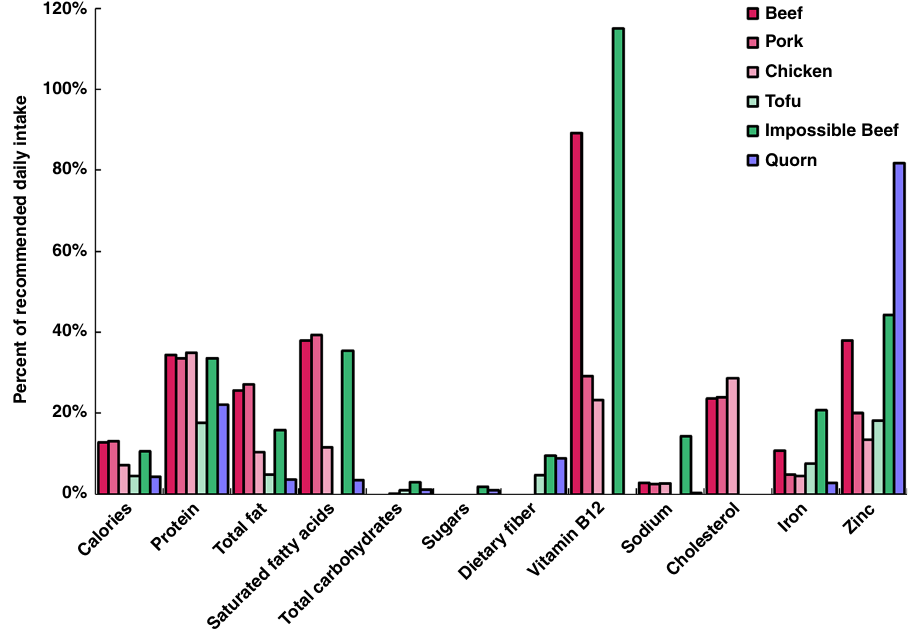
Fig. 4 Nutritional value of ABM (beef, pork, and chicken), traditional PBM (tofu), novel PBM (Impossible ™ Beef), and mycoprotein (Quorn ™ ) per 100 g wet weight, raw. Nutritional data for ABM and tofu were obtained from the FoodData Central database (FDC ID: 174036, 167902, 171116, 388713) and Impossible ™ and Quorn ™ data were obtained from company websites. Content is quanti fi ed by the percent of recommended daily intake as determined by the FDA 94